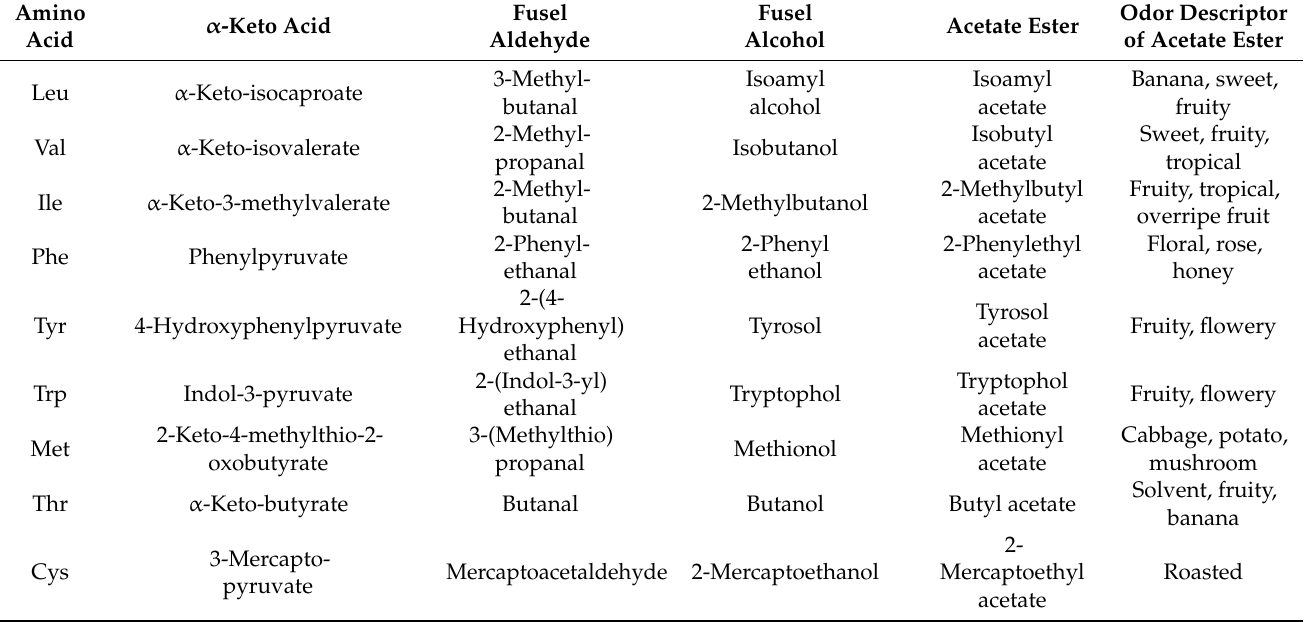
Table 1. Ehrlich pathway intermediates and derivates of branched-chain amino acids (Leu, Val, Ile), aromatic amino acids (Phe, Tyr, Trp), the sulfur-containing amino acids (Met, Cys) and the polar-uncharged amino acid (Thr) as well as the odor descriptors of their acetate esters. Modified from Dzialo et al. [7], Valera et al. [21] and Vermeulen et al.